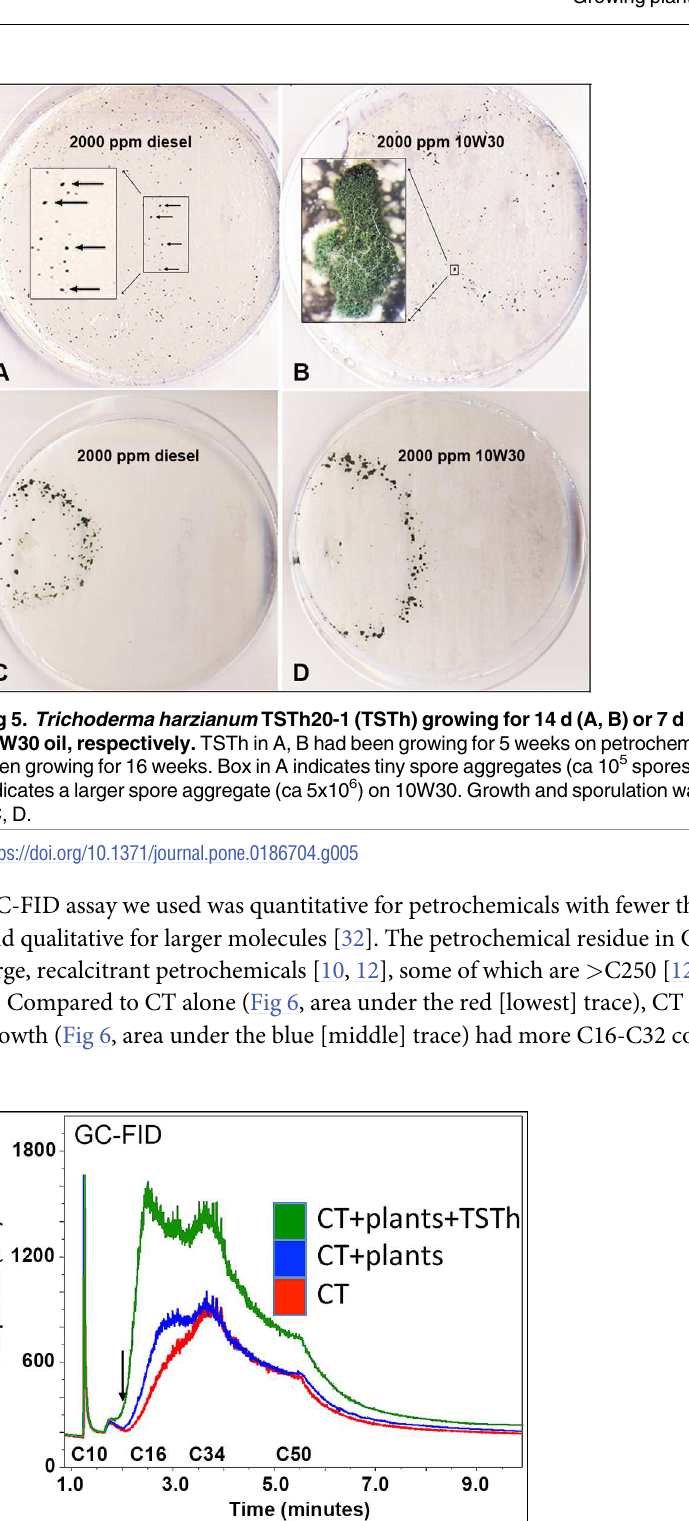
Fig 6. Plants colonized with Trichoderma harzianum TSTh20-1 (TSTh) mobilized petrochemicals across a broad size range. Plants colonizedwith TSTh (area under the green [top] trace) had twice the petrochemical mobilizationas plants alone (area under blue [middle] trace), and tailing sand (TS; area under red [bottom] trace). Petrochemicals larger than C14 (arrow) are not volatile.